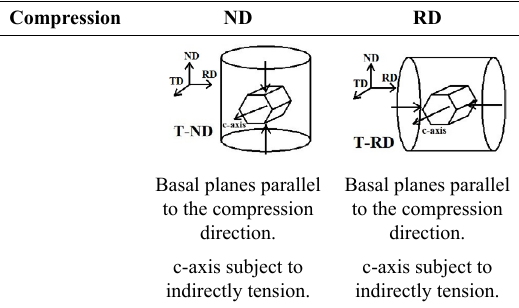
Besides, comparing the pre-deformed samples and the as-received samples at three strain rates, we found that the strain rate sensitivity does not change after metal pre- deformation. The flow stress of AZ31 magnesium alloy is not sensitive to the quasi-static strain rate.